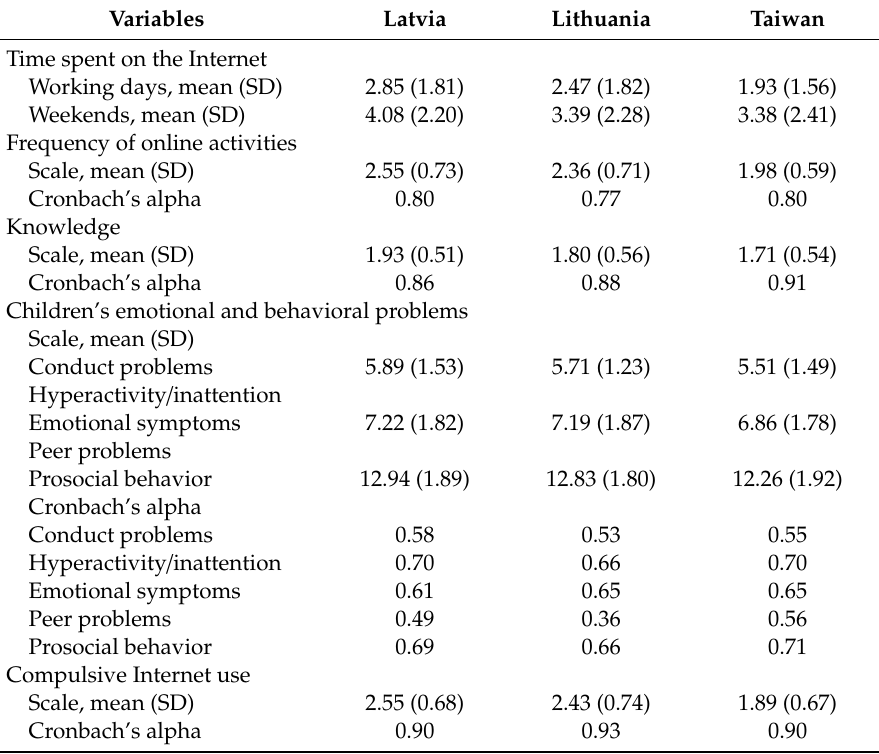
Table 2. Means and standard deviations of the variables used in the data